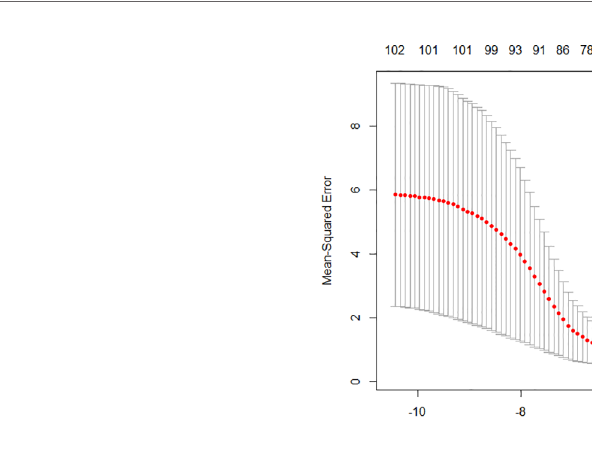
FIGURE 2 | The tenfold cross-validation was repeated 100 times to generate the optimal value in the LASSO model. Six non-zero coef fi cients were chosen at the standard of lambda that gave the minimum binomial